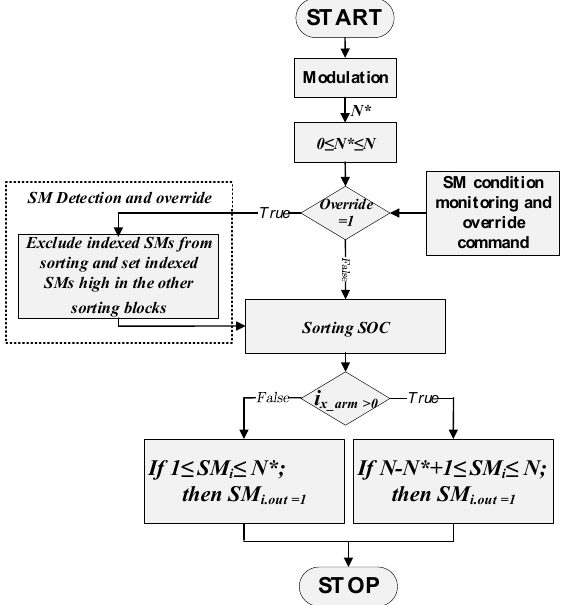
Figure 4. Sorting algorithm with SM-EB override capability.